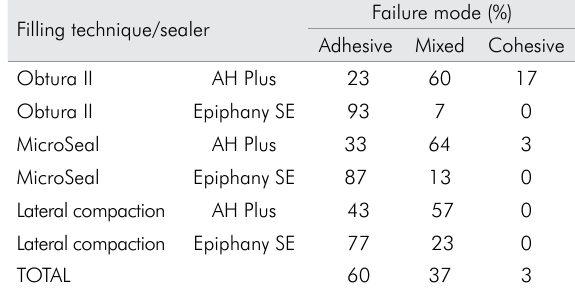
Table 2. Distribution of the mode of failure after the displacement of the filling material from the specimens in each group during the push-out